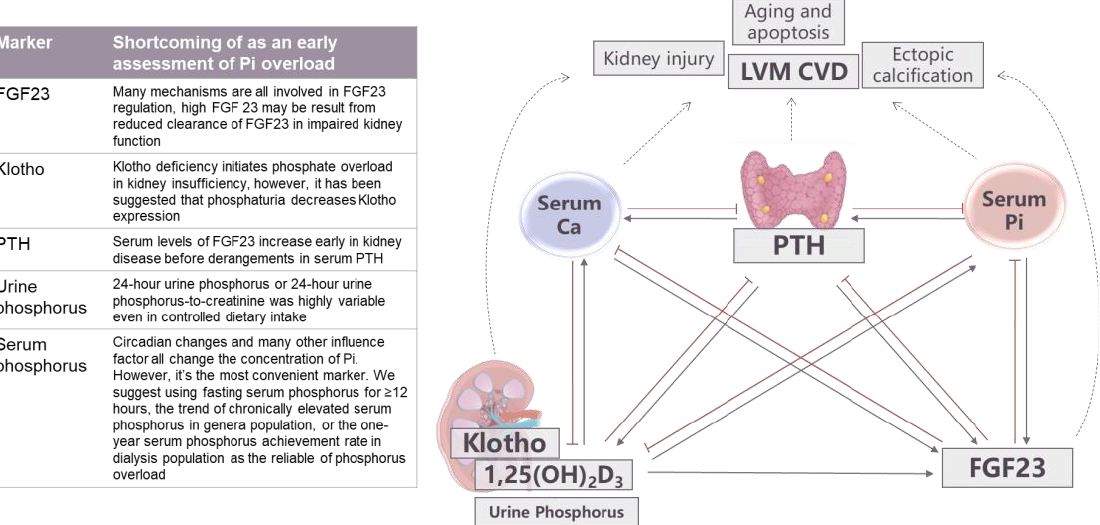
Figure 6. Early markers of phosphorus overload. Note: The arrows represent the promotion or inhibition effects.